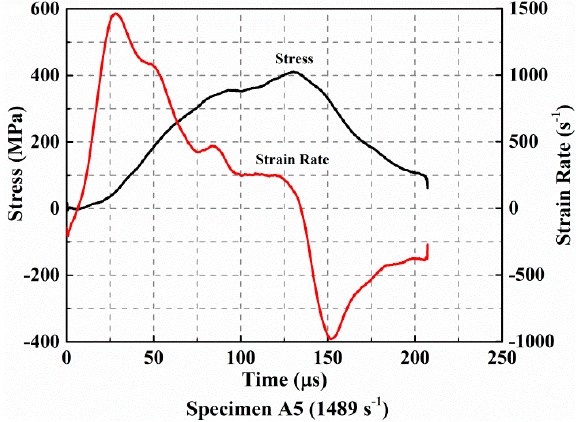
Figure 6. Evolution of the stress and strain rate curves during loading when the specimen has not undergone complete failure.